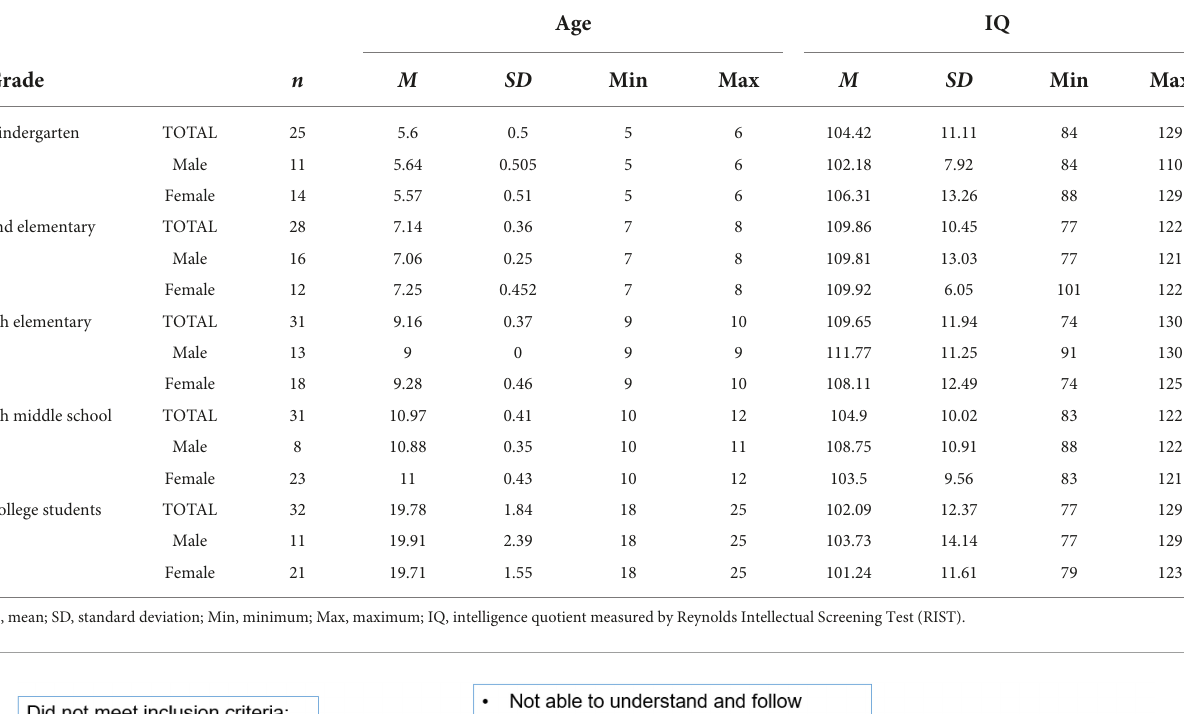
TABLE 1 Sociodemographic descriptive statistics of the final sample for age and IQ.